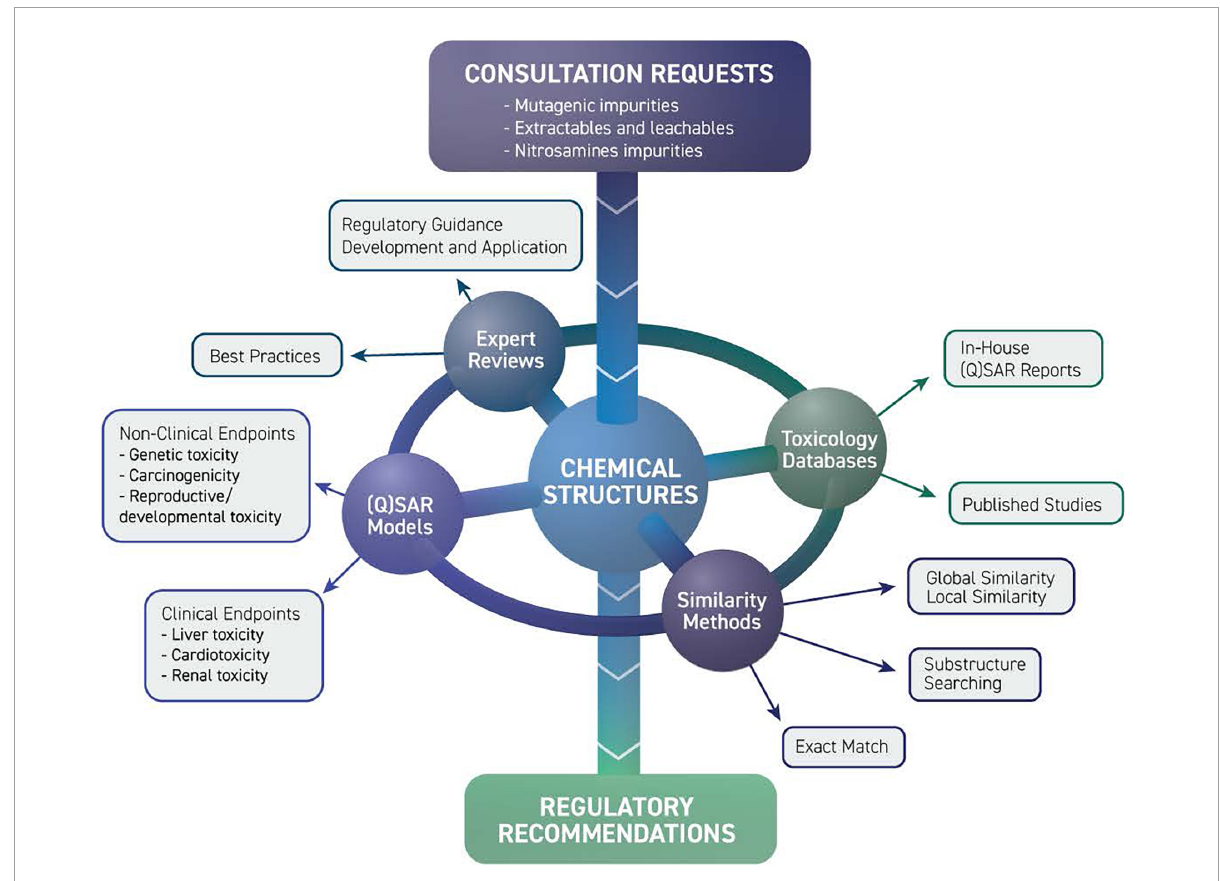
FIGURE12 Limiting drug impurities and extractable/leachable compounds division of applied regulatory science (DARS) computational toxicology consultation service receives consult requests from across CDER. Experts review model predictions using a combination of toxicology databases, similarity methods, and (quantitative) structure-activity relationship [(Q)SAR] models before a regulatory recommendation is